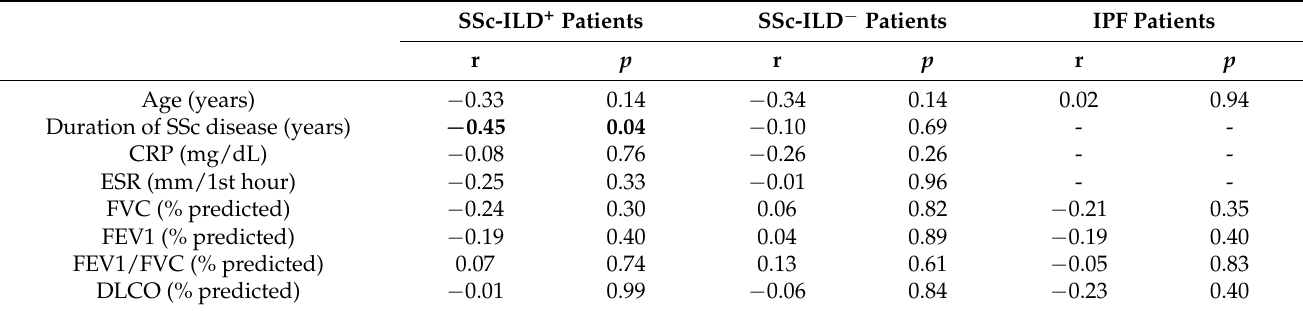
Table 2. Correlation of EPC frequency with continuous variables related to demographic and disease